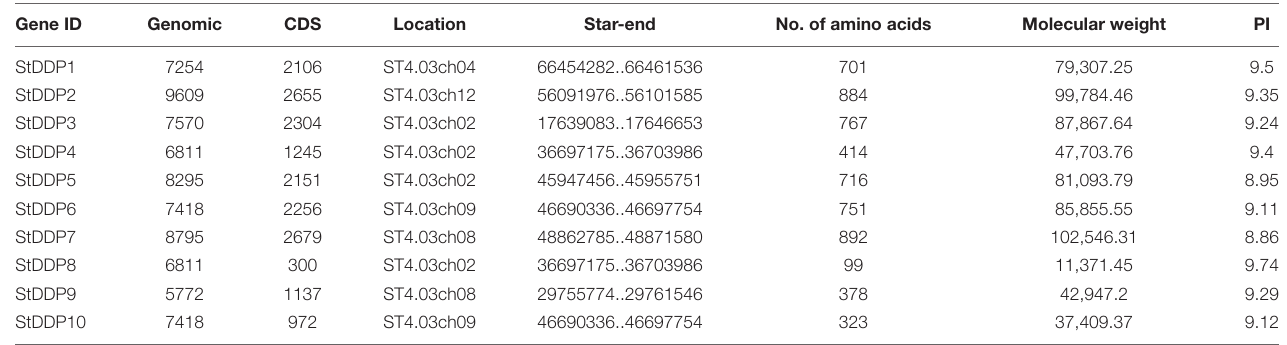
TABLE 1 | List of identified putative StDDPs and their